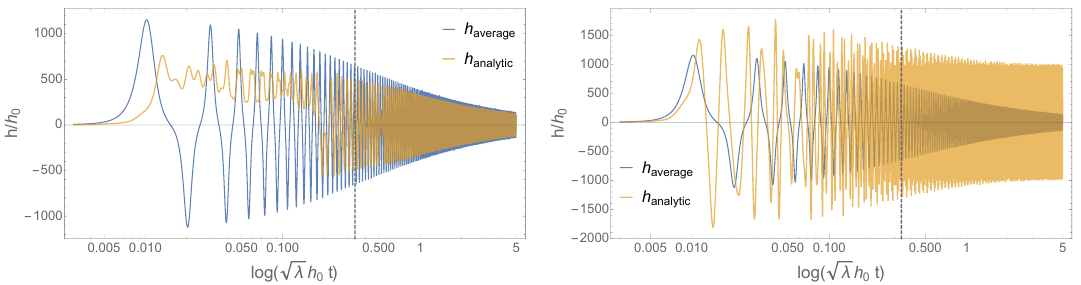
Figure 12 . The evolution of Higgs with the mass parameter m (cid:30) = (cid:3) 2 (cid:12) = 0 (left panel) and (cid:12) = (cid:25)= 4 (right panel). The blue-solid line shows the result from a smoothed in(cid:13)aton density. The dashed line is the time when maximum temperature is